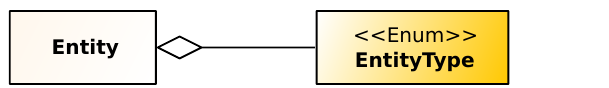
Figure 21: A UML representation of the Entity class for the Systems Biology Graphical Notation - Markup Language. See Section 2.1 for conventions related to this figure.